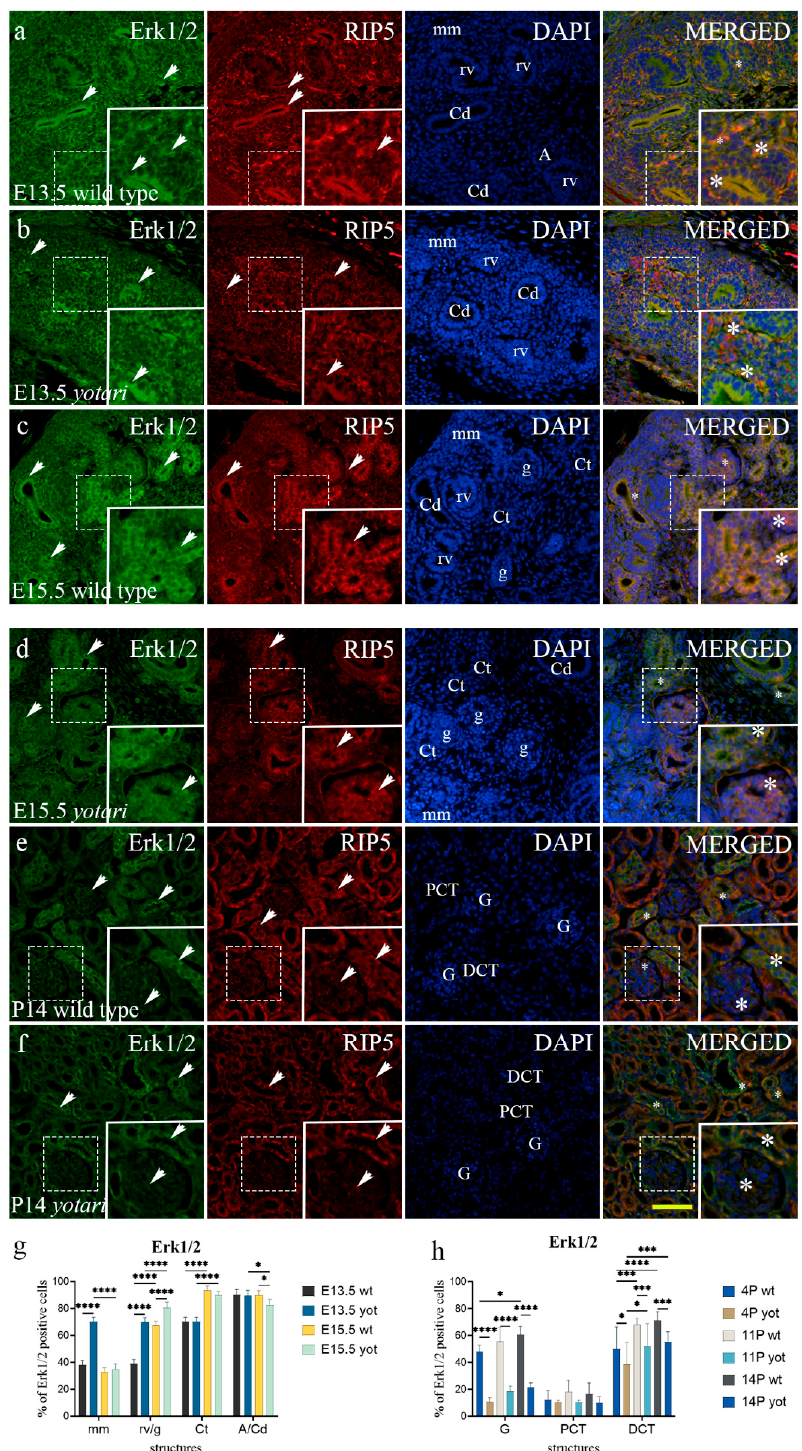
Figure 5. Double immunofluorescence staining of embryonic wild-type ( a , c ) and yotari ( b , d ) and postnatal wild-type ( e ) and yotari ( f ) mouse kidneys with the Erk1/2 and RIP5 markers. Arrows show the expression pattern of Erk1/2 and RIP5 in the mesenchyme (mm), renal vesicles (rv), immature glomeruli (g), convoluted tubules (Ct), ampullae (A), and collecting ducts (Cd), glomeruli (G), proximal convoluted tubules (PCT) and distal convoluted tubules (DCT) indicated on the 4 ′ ,6- diamidino-2-phenylindole (DAPI) image. Immunoexpression of Erk1/2, RIP5, DAPI staining and merged Erk1/2, RIP5, and DAPI at embryonic days E13.5 and E15.5 in wild type ( a , c ) and yotari ( b , d ). Immunoexpression of Erk1/2, RIP5, DAPI staining and merged Erk1/2, RIP5, and DAPI at postnatal day 14 (P14) in wild type ( e ) and yotari ( f ). Wild-type and yotari mice at postnatal day 4 (P4) and 11 (P11) of kidney development mostly correspond regarding localization and intensity of Erk1/2; thus, a representative image was selected from P14. The most prominent protein expression area is shown in inserts, corresponding to the dashed boxes. An asterisk denotes the zone where co- expression was detected. Images were taken on magnification ×40. The scale bar is 50 μ m, which refers to all images. The distribution of the percentages of Erk1/2 positive cells in the metanephric mesenchyme (mm), renal vesicles (rv) or glomeruli (g), convoluted tubules (Ct), and ampulla (A) or collecting ducts (Cd) of wild type and yotari kidneys at embryonic days E13.5 and E15.5 ( g ). The distribution of the percentages of Erk1/2 positive cells in the glomeruli (G), proximal convoluted tubules (PCT), and distal convoluted tubules (DCT) of postnatal kidneys of wild type and yotari animals over time (P4, P11, P14) ( h ). Data are presented as the mean ± SD (vertical line) and analyzed by a two-way ANOVA test followed by Tukey’s multiple comparison test. Significant differences were indicated by * p < 0.05, *** p < 0.0001, **** p < 0.00001. At each embryonic time point, ten substructures were assessed. At each postnatal time point, twenty substructures were assessed.